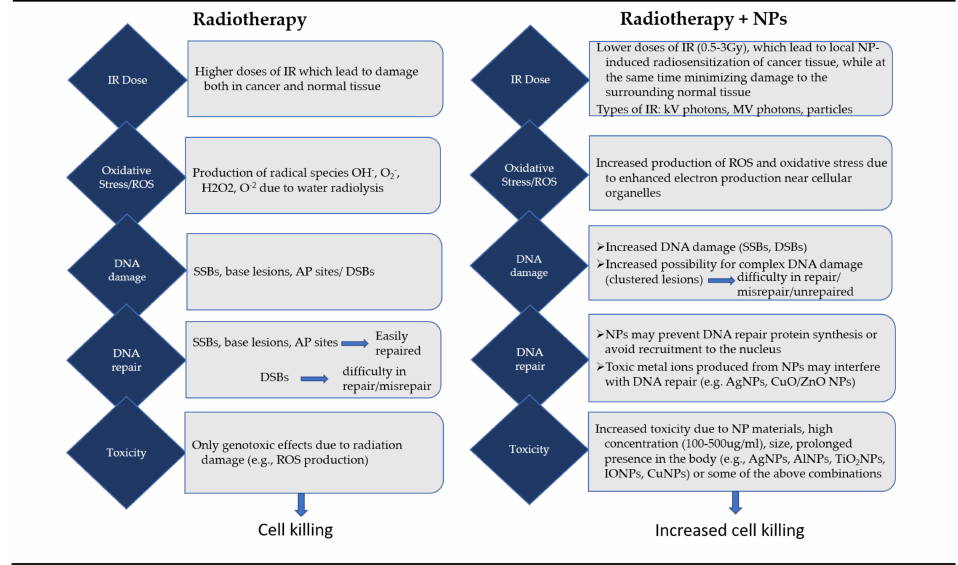
Figure 3. A summary of key point differences between RT and combined NP